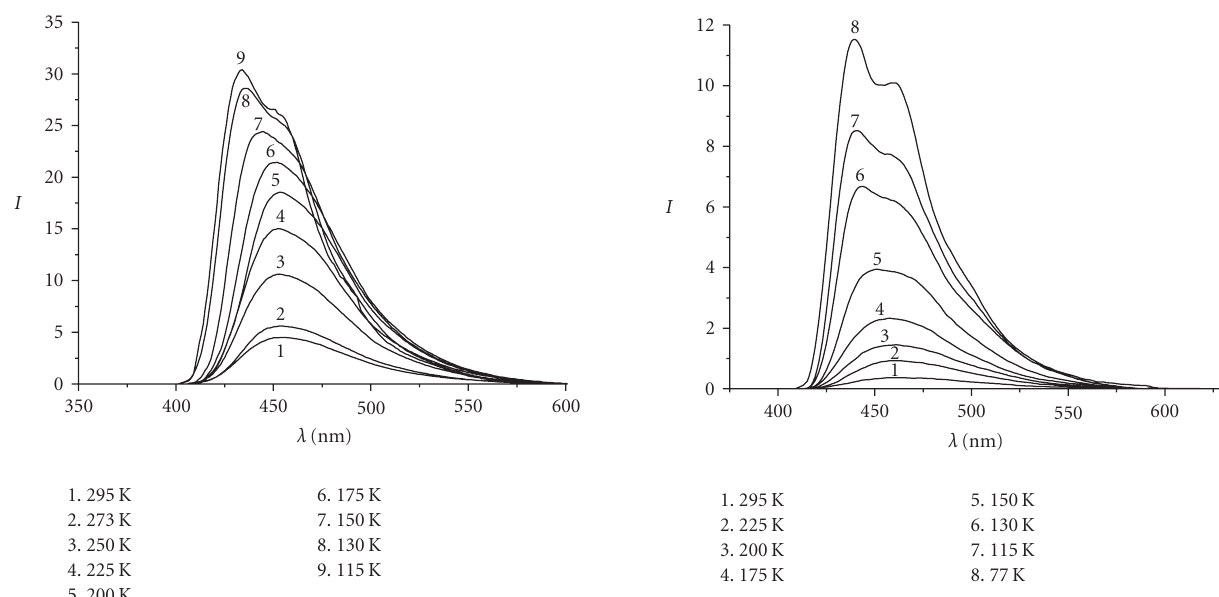
Figure 2: The fluorescence spectra of I in ethanol at di ff erent tem- peratures.